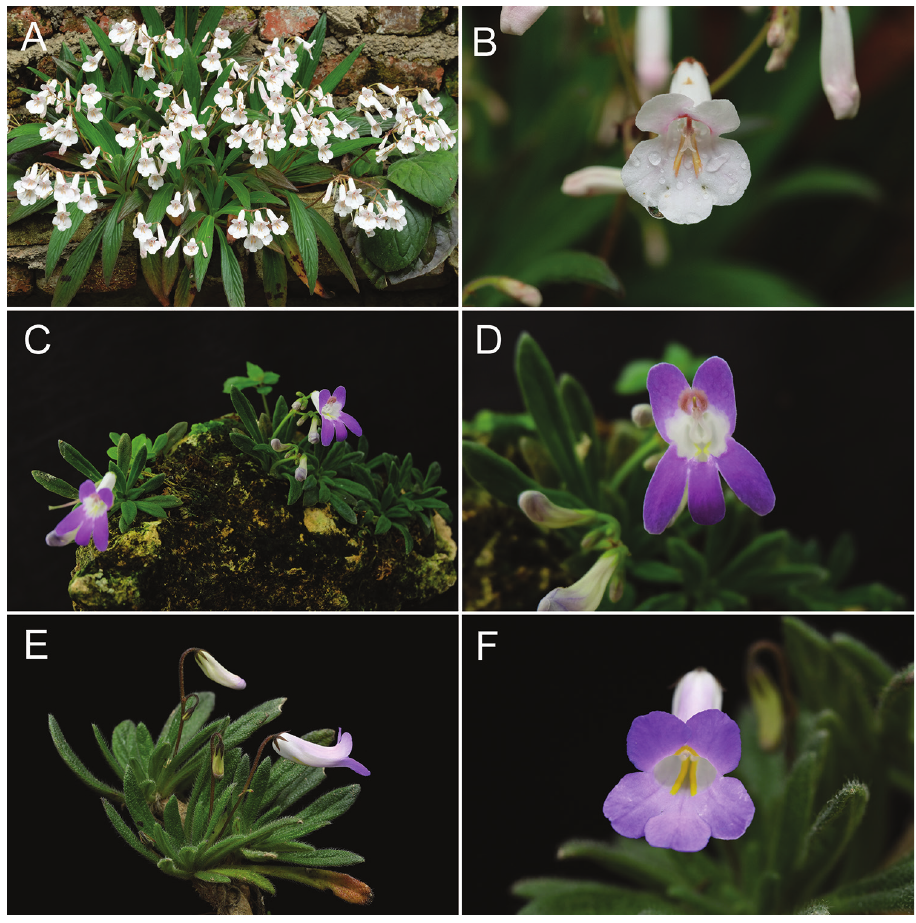
Figure 2. Comparison of three species of Primulina A, B P. linearifolia C, D P. pseudolinearifolia E, F P. papillosa . (photos by F. Wen; arranged by Z.B. Xin).